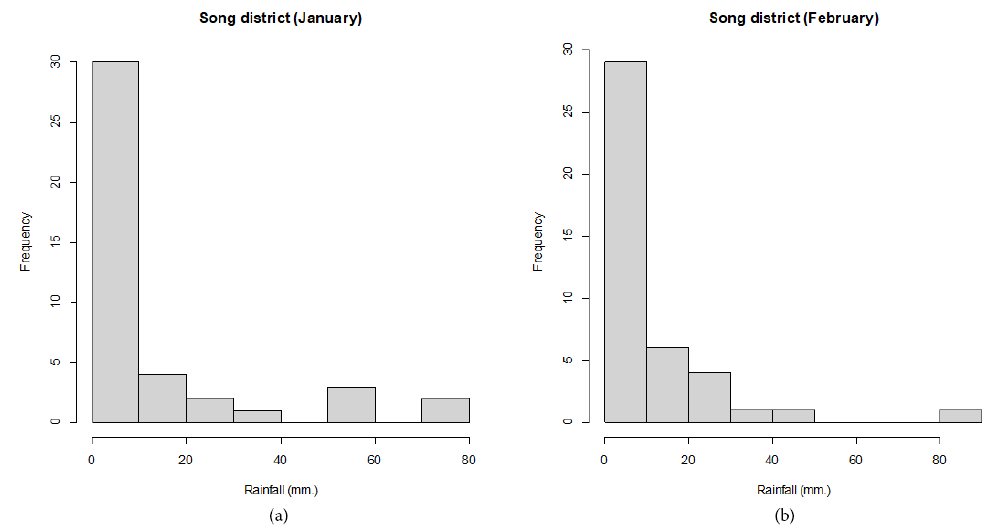
Figure 5. The densities of the rainfall data from Song district station, Phrae province, Thailand, for ( a ) January and ( b ) February from